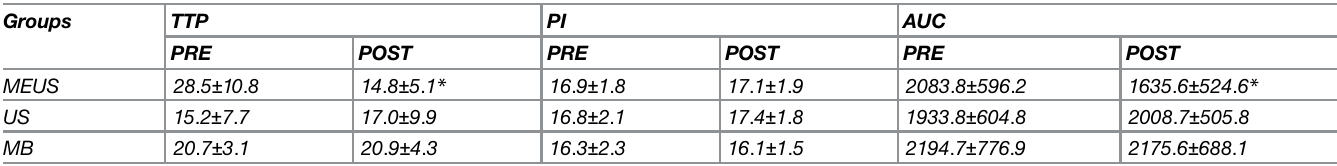
Data are expressed as the means ± standard deviations. MEUS, microbubble-enhanced ultrasound; US, ultrasound; MB, microbubbles; TTP, time to peak, unit in seconds; PI, peak intensity, unit in dB; AUC, means area under curve, unit in dB (cid:1) s * Indicates signi fi cant differences from the PRE values ( p <